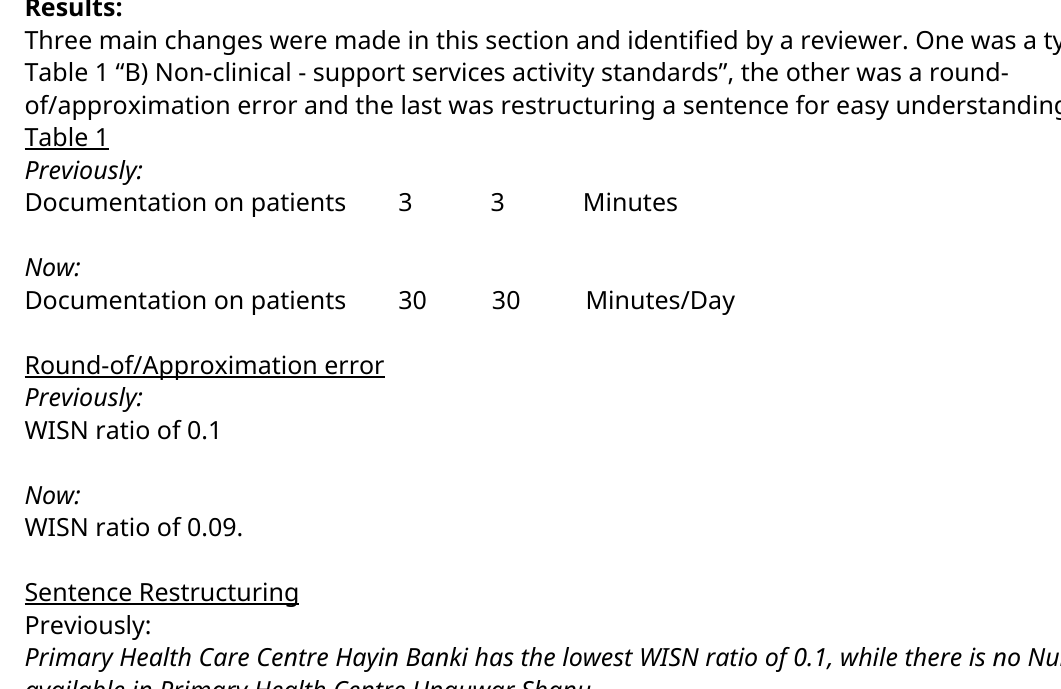
Previously: Documentation on patients